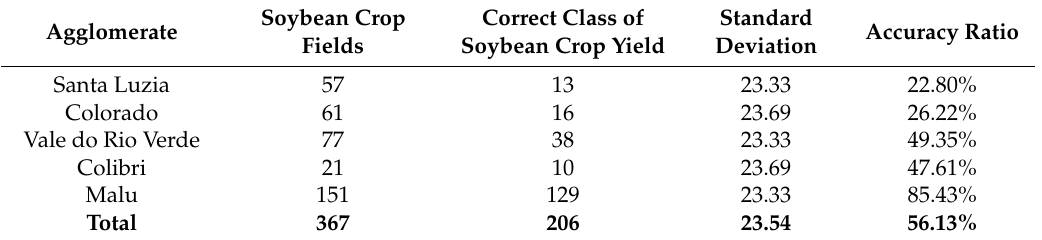
Table 3. Yield classification errors detected by the punctual crop field analysis.